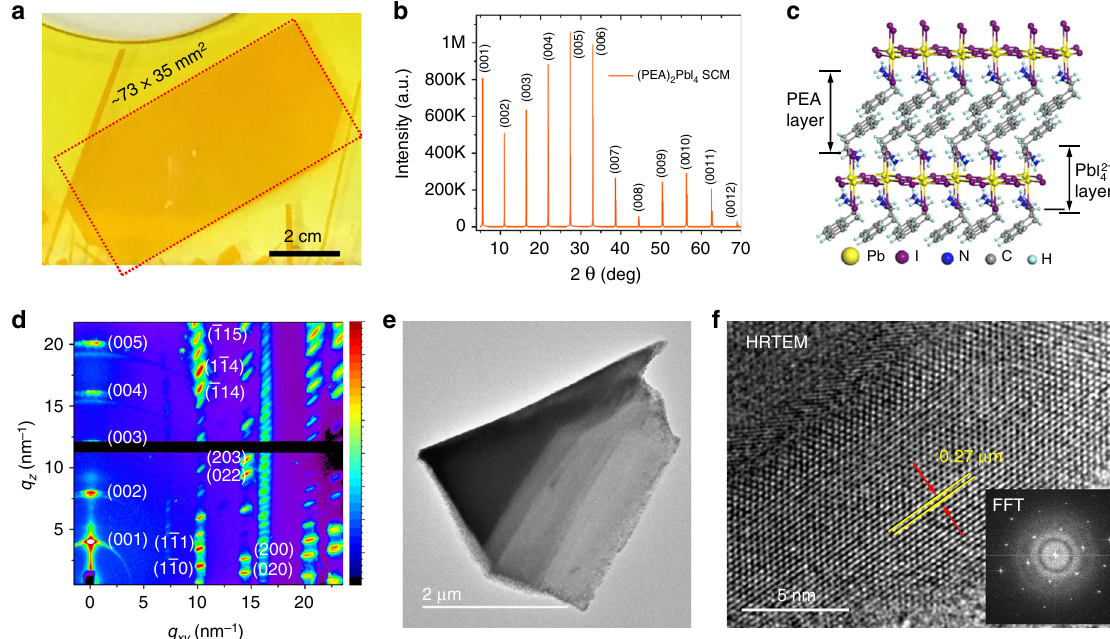
Fig. 4 Structural of (PEA) 2 PbI 4 SCM. a Photo of the (PEA) 2 PbI 4 SCM sample (73 × 35 mm 2 ) used for XRD measurements. b XRD pattern of the (PEA) 2 PbI 4 SCM. c Layered crystal structure of the (PEA) 2 PbI 4 . d GIWAXS image of the 2D layered (PEA) 2 PbI 4 SCM. e , f TEM image and HRTEM image of a (PEA) 2 PbI 4 SCM, with the d-spacing measured assigned to the (006) lattice